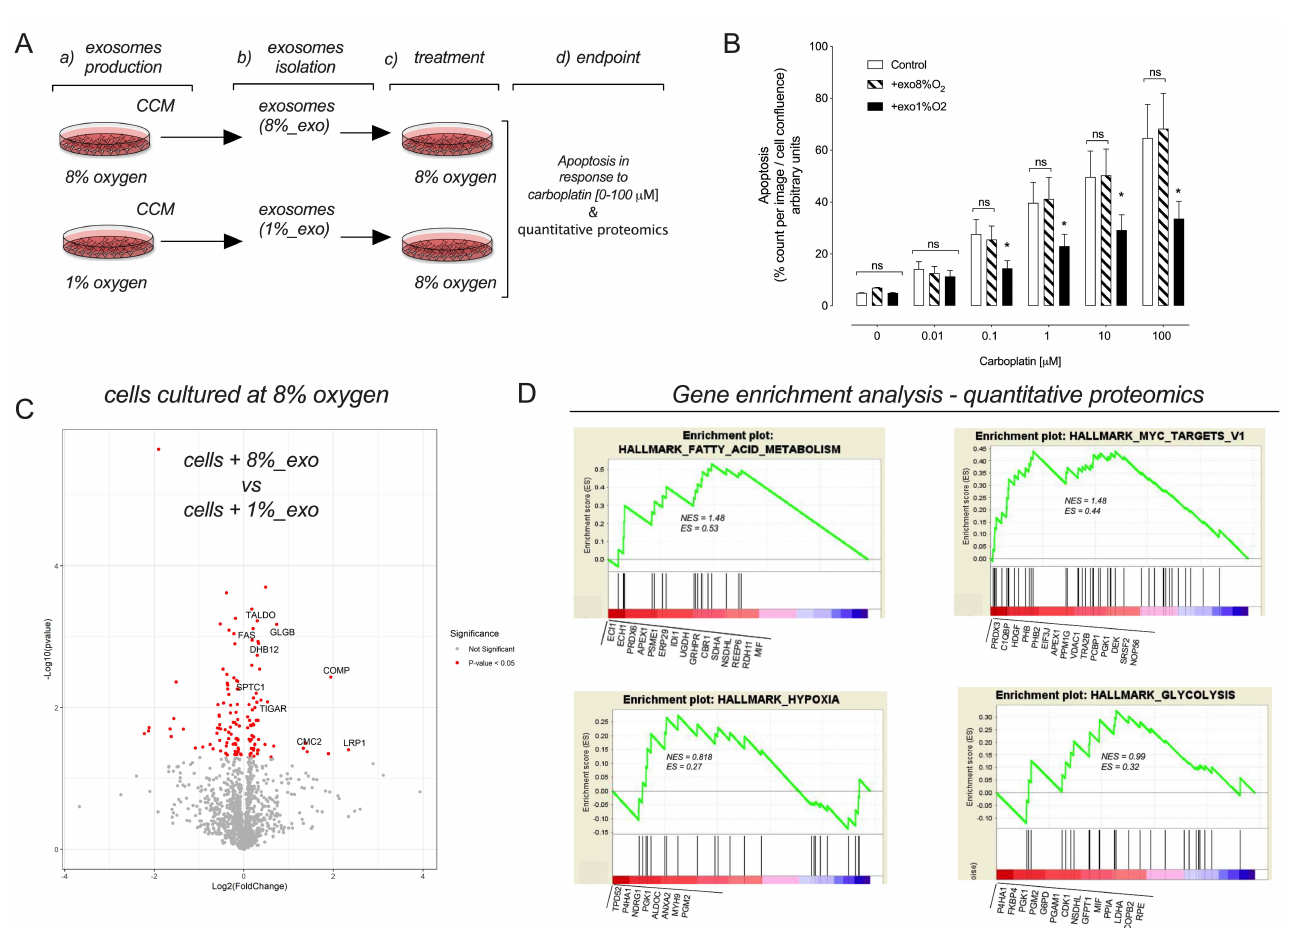
Figure 9. 1% O 2 sEVs induced chemoresistance in 8% O 2 CAOV-3 cells. ( A ) Experimental strategy. ( B ) Apoptosis in 8% O 2 CAOV-3 cells exposed to 8% O 2 sEVs, 1% O 2 sEVs, or